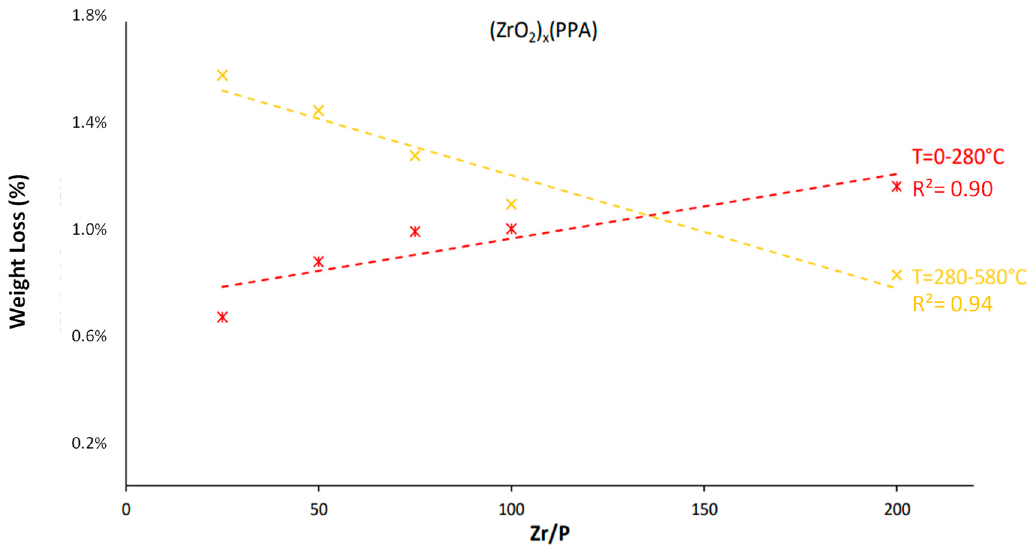
Figure A3. Variation of organic weight loss in the range of 0–280°C and 280–580 °C in thermogravimetric analysis as a function of the starting Zr/P ratio for (ZrO 2 ) x (PPA) Samples.